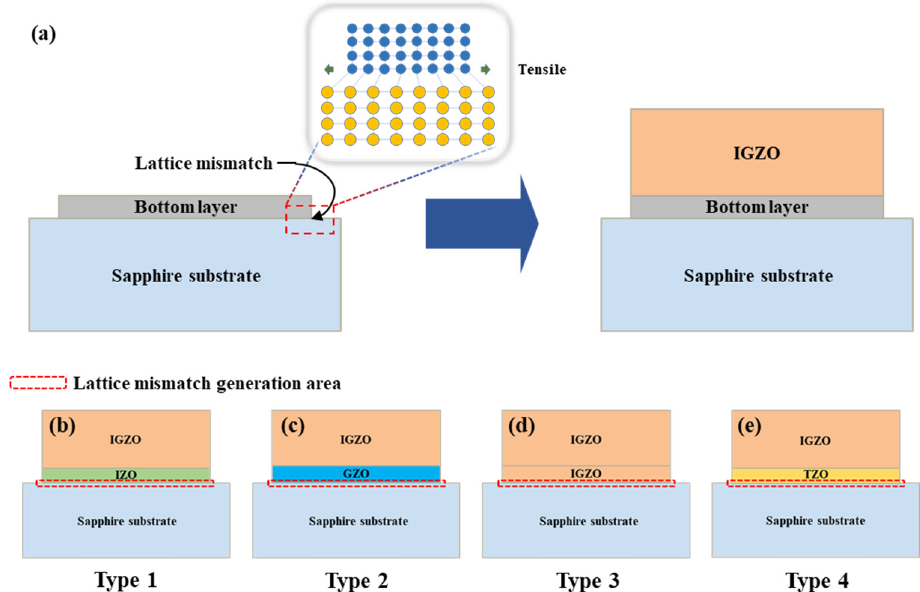
Figure 1. The overview of thin film structure ( a ) and the schematic diagram of 4 types of (In, Ga) co-doped ZnO multilayered thin film structures: Type 1 ( b ), Type 2 ( c ), Type 3 ( d ), Type 4 ( e ).